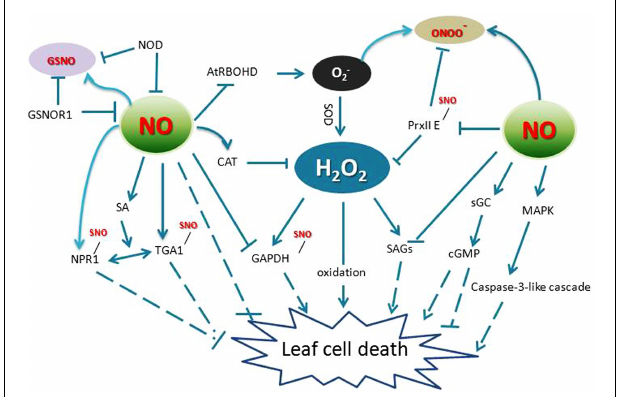
FIGURE 2 | Crosstalk of RNS and ROS in leaf cell death. AtRBOHD, an NADPH oxidase; GAPDH, glyceraldehyde 3-phosphate dehydrogenase; GSNO, S -nitrosoglutathione; GSNOR1, S -nitrosoglutathione reductase 1; NPR1, non-expression of pathogenesis related protein 1;TGA1,TGACG motif binding factor 1; NR, nitrate reductase; SAG, senescence-associated genes; PrxII E, peroxiredoxin II E; NOD, NO degrading dioxygenase; sGC, soluble guanylate cyclase. MAPK, mitogen-activated protein kinase; SOD, superoxide dismutase; CAT, catalase; cGMP, cyclic guanosine monophosphate; sGC, soluble guanylate